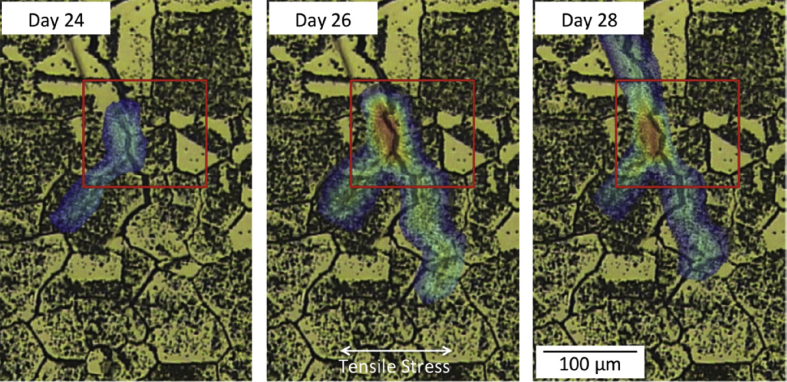
In situ observation of sensitised 304 stainless steel in a windowed autoclave, exposed to high-temperature, high-purity, oxygenated water (250 °C; 1 ppm O2; 50 atm). The colour overlay relates to the level of strain obtained by digital image corellation, from the crack opening displacement, with high-strain represented by red, and low strain dark blue. From Stratulat et al. [2014].7